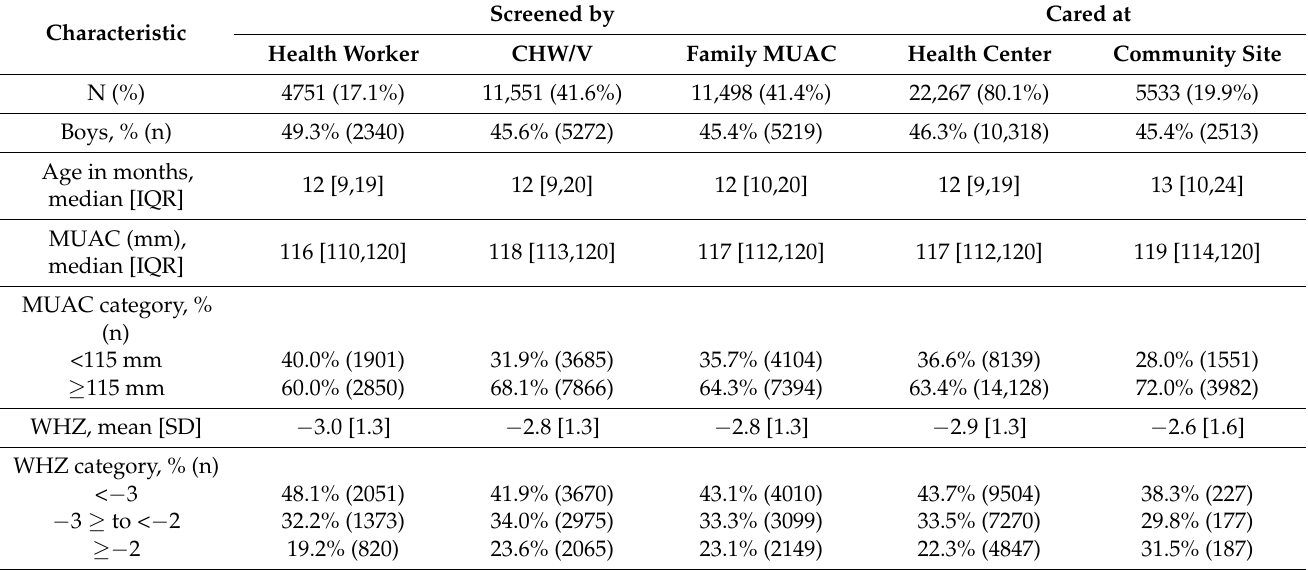
Table 2. Baseline characteristics of children admitted to simplified, combined treatment according to screening and treatment